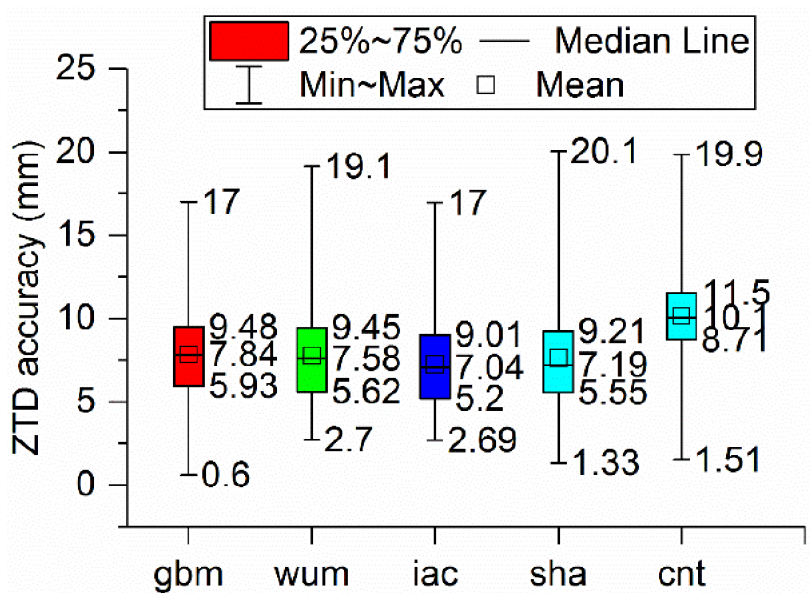
Figure 10. Boxplot of the ZTD accuracy derived from BDS-3 PPP in coordinate-fixed mode with five precise